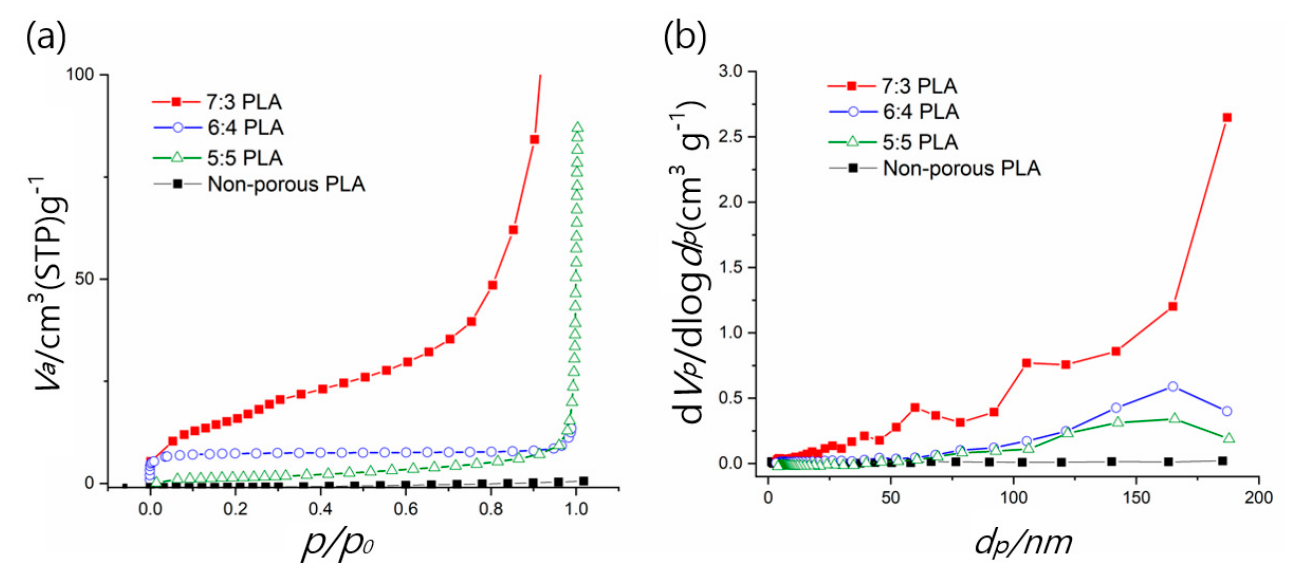
Figure 3. ( a ) N 2 adsorption isotherms and ( b ) pore size distribution (BJH) plots of non-porous and porous PLA fibers (5:5, 6:4, and 7:3 PLA).